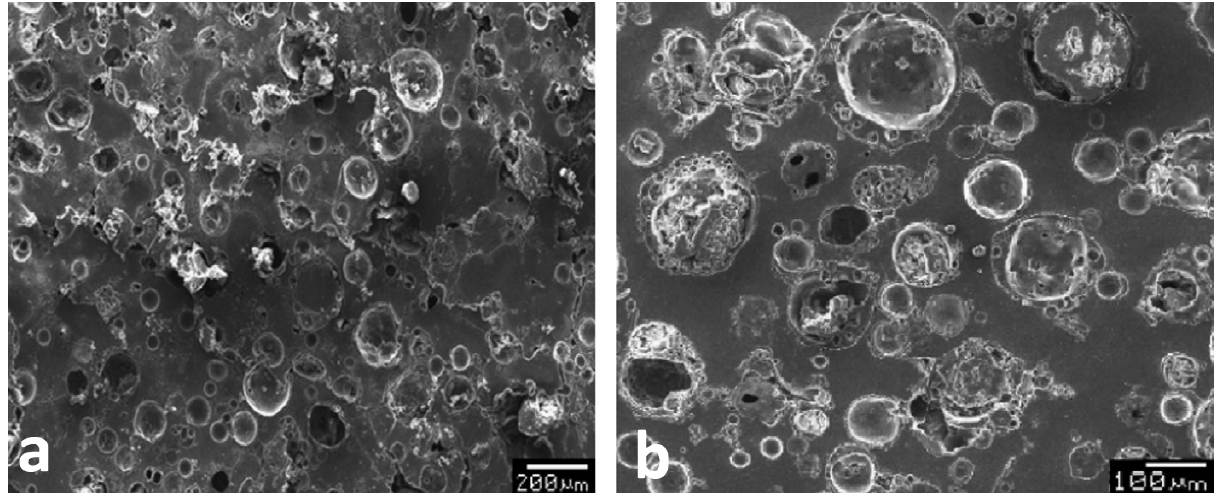
Figure 4: Microstructure of the aluminium-cenospheres syntactic foams